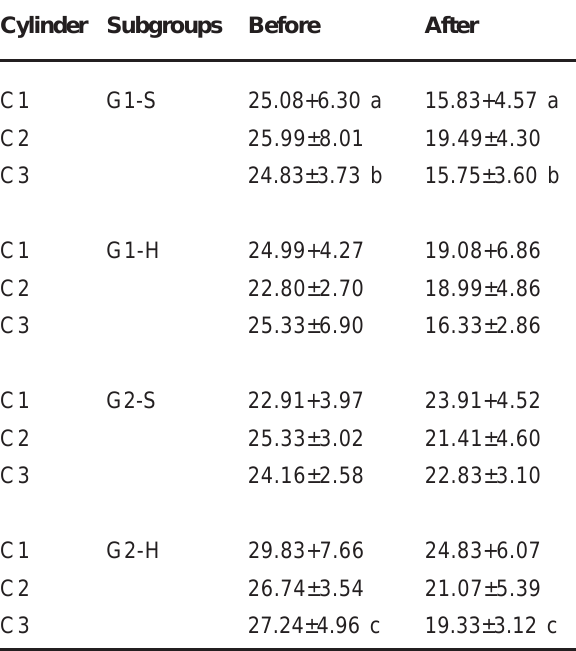
C= cylinder, S= slotted screw, H= hexagonal screw, G1 = titanium alloy. G2 = cobalt-chromium alloy Small letters represent statiscally significant differences in the same line ( α